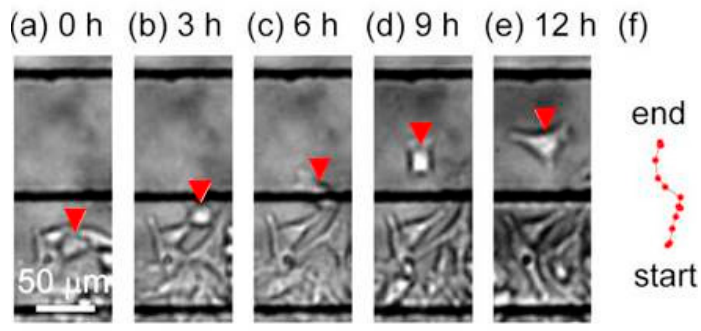
Figure 9. Screening for a high-migratory cell. ( a ) 0 h, ( b ) 3 h, ( c ) 6 h, ( d ) 9 h, and ( e ) 12 h, ( f ) the trajectory of the high-migratory cell traced every hour.